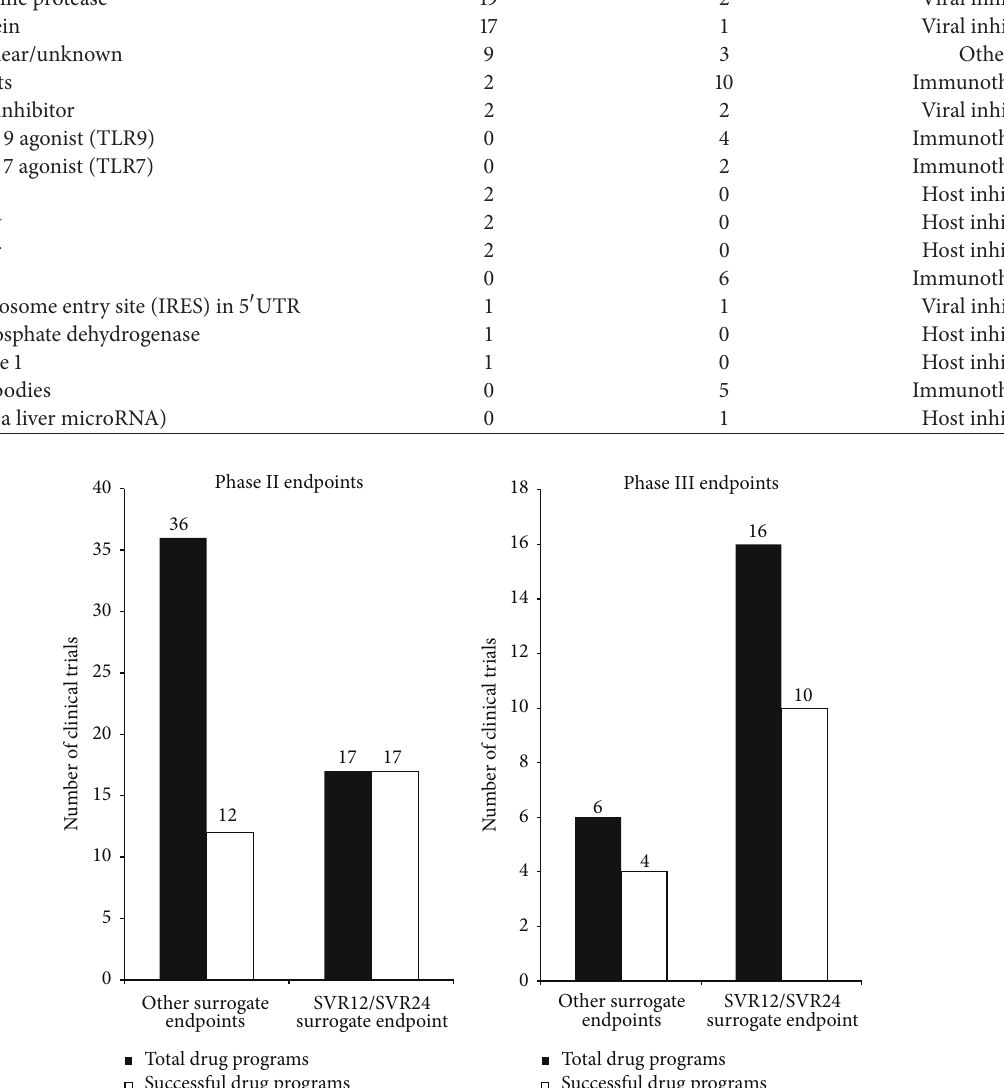
Figure 3: Endpoint selection. The surrogate endpoints for the phase II and III clinical trials were categorized based on the FDA recommended primary surrogate endpoint, SVR12/SVR24. Other surrogate endpoints included changes in baseline level of HCV RNA, EVR, RVR, SVR48, SVR72, and normalization of ALT levels. The success rates of drug trials with other surrogate endpoints versus those with the SVR12/SVR24 endpoints were contrasted by observing the total drug programs versus the successful